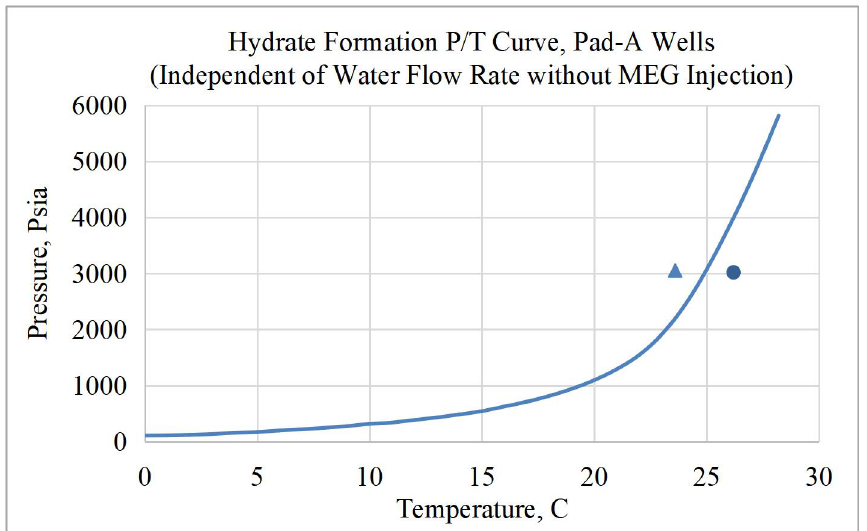
Figure 6—Hydrate formation curve without MEG